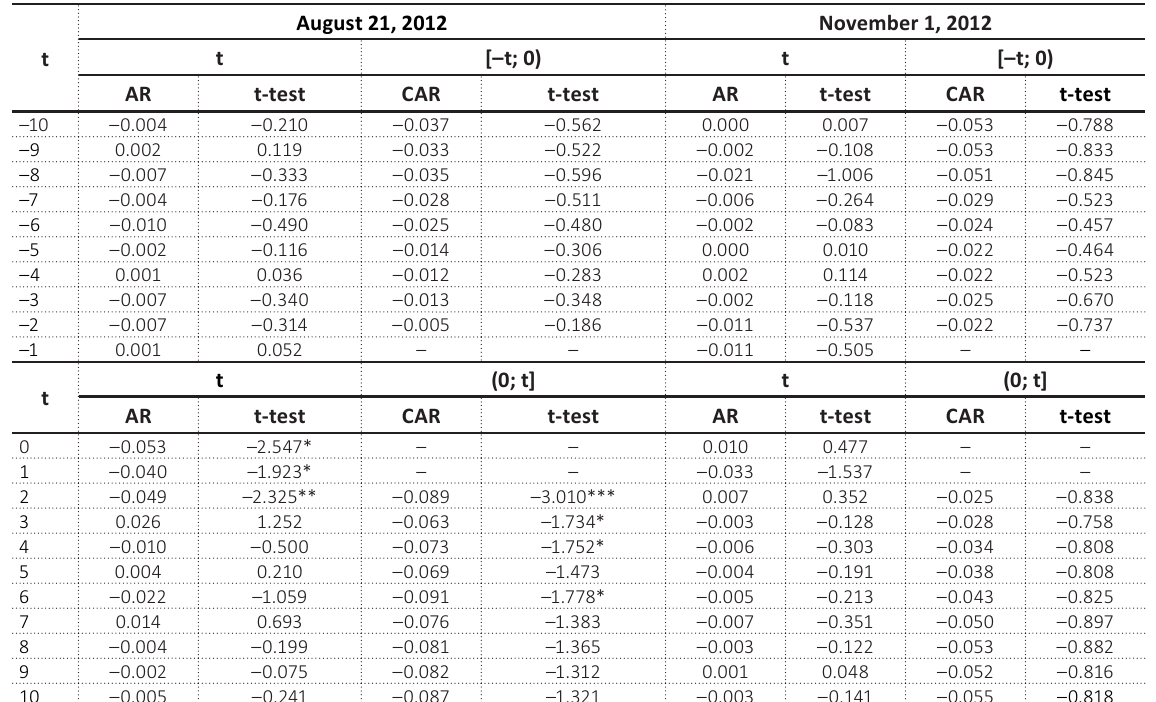
Table 2. Results of abnormal returns and cumulative abnormal returns of